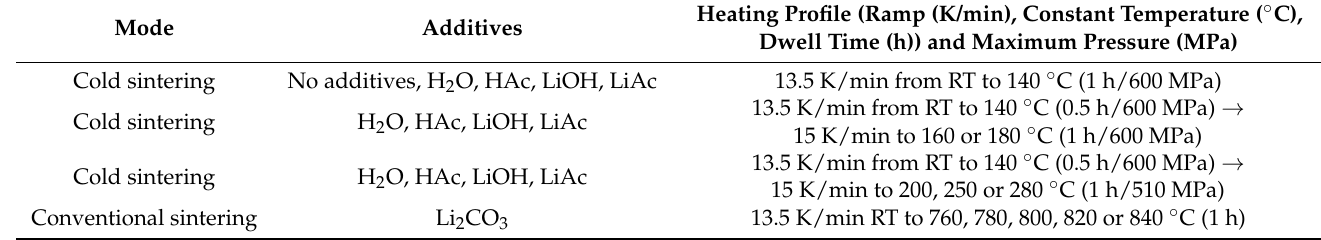
Table 1. Summary of the sintering parameters. Heating Profile (Ramp (K/min), Constant Temperature ( ◦ C), Mode Additives Dwell Time (h)) and Maximum Pressure